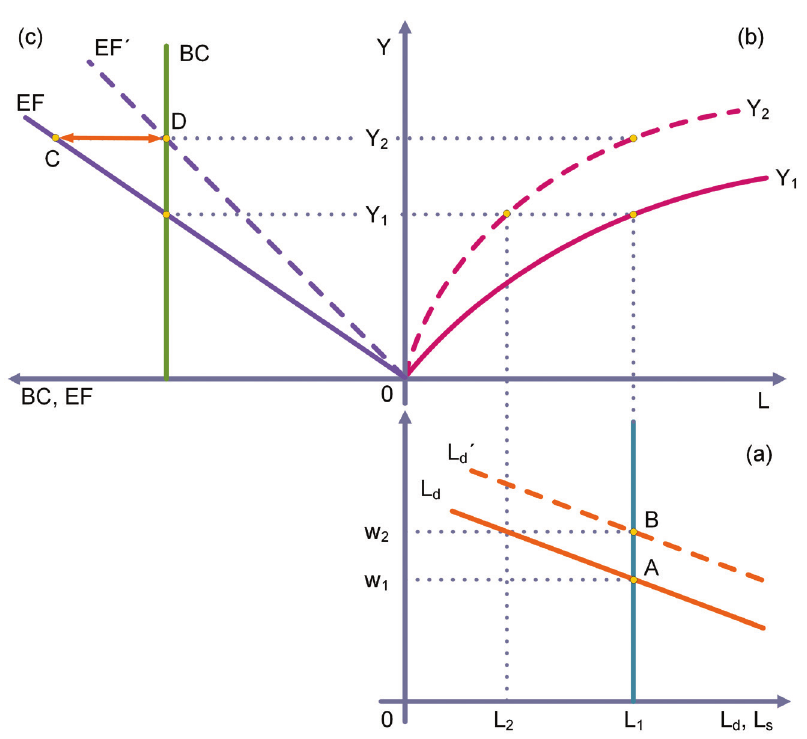
Figure 2: Increase of ecological deficit following an improvement in